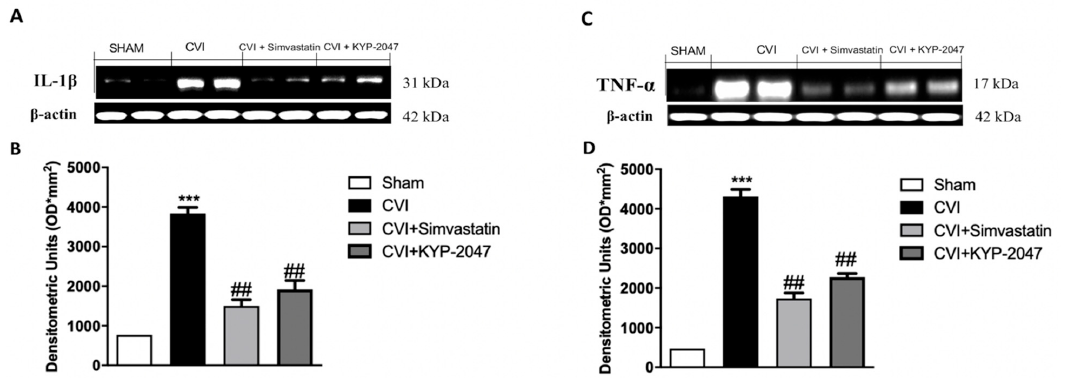
Figure 4. Treatment with KYP-2047 on cytokines expression. IL-1 β and TNF- α expression levels, monitored by Western blotting in saphene veins tissue, were increased in CVI group, compared to sham basal levels respectively ( A ), see the densitometric units score ( B ) and ( C ), see the densitometric units score ( D ). KYP-2047 administration (10 mg/kg, i.p.) significantly reduced both cytokines proteins expression, similar to the election treatment represented by Simvastatin (20 mg/kg, oral) respectively ( A ), see the densitometric units score ( B ) and ( C ), see the densitometric units score ( D ). Data represent the means of at least three independent experiments. One-way ANOVA followed by Bonferroni post-hoc. *** p < 0.001 versus Sham; ## p < 0.01 versus